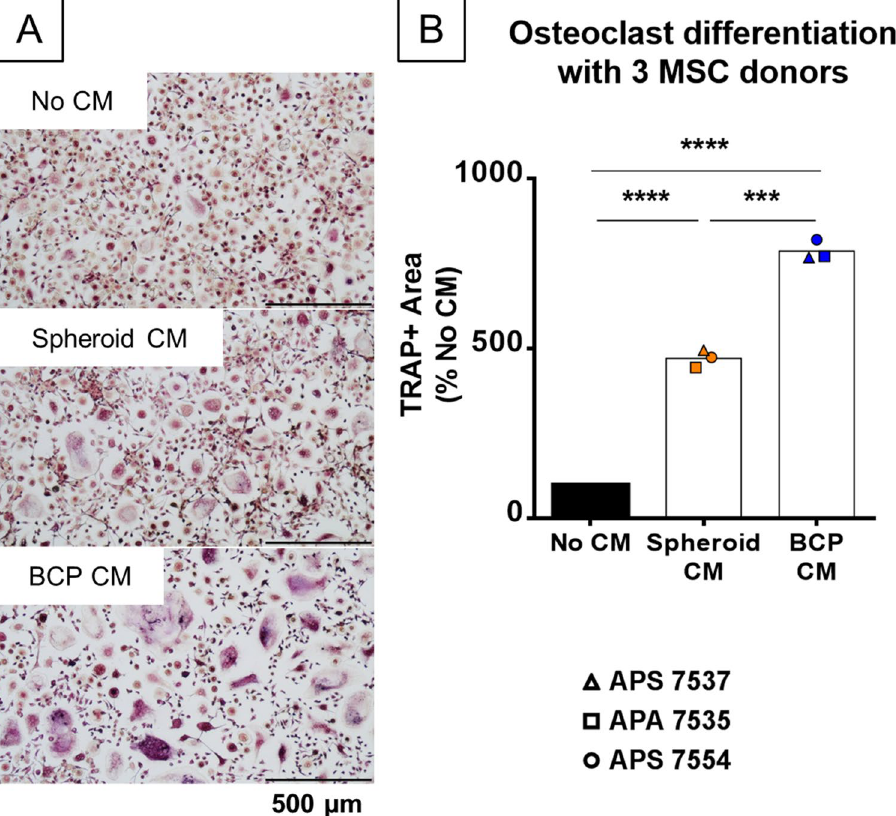
Figure 1. Osteoclastogenesis is enhanced in vitro by CM from MSCs culture on BCP material. ( A ) Microscopic images of TRAP-stained osteoclasts culture without CM, with CM from MSC spheroids (Spheroid CM) or MSCs on BCP material (BCP CM). ( B ) Quantification by image analysis of TRAP+ area after 8 days of osteoclast differentiation with spheroid or BCP CM from three MSC donors, normalized to the TRAP+ area without CM. N = 3 independent experiments with technical triplicate. Statistical analysis by repeated measure ANOVA followed by Tukey’s multiple comparison test, *** for p value < 0.001, **** for p value <